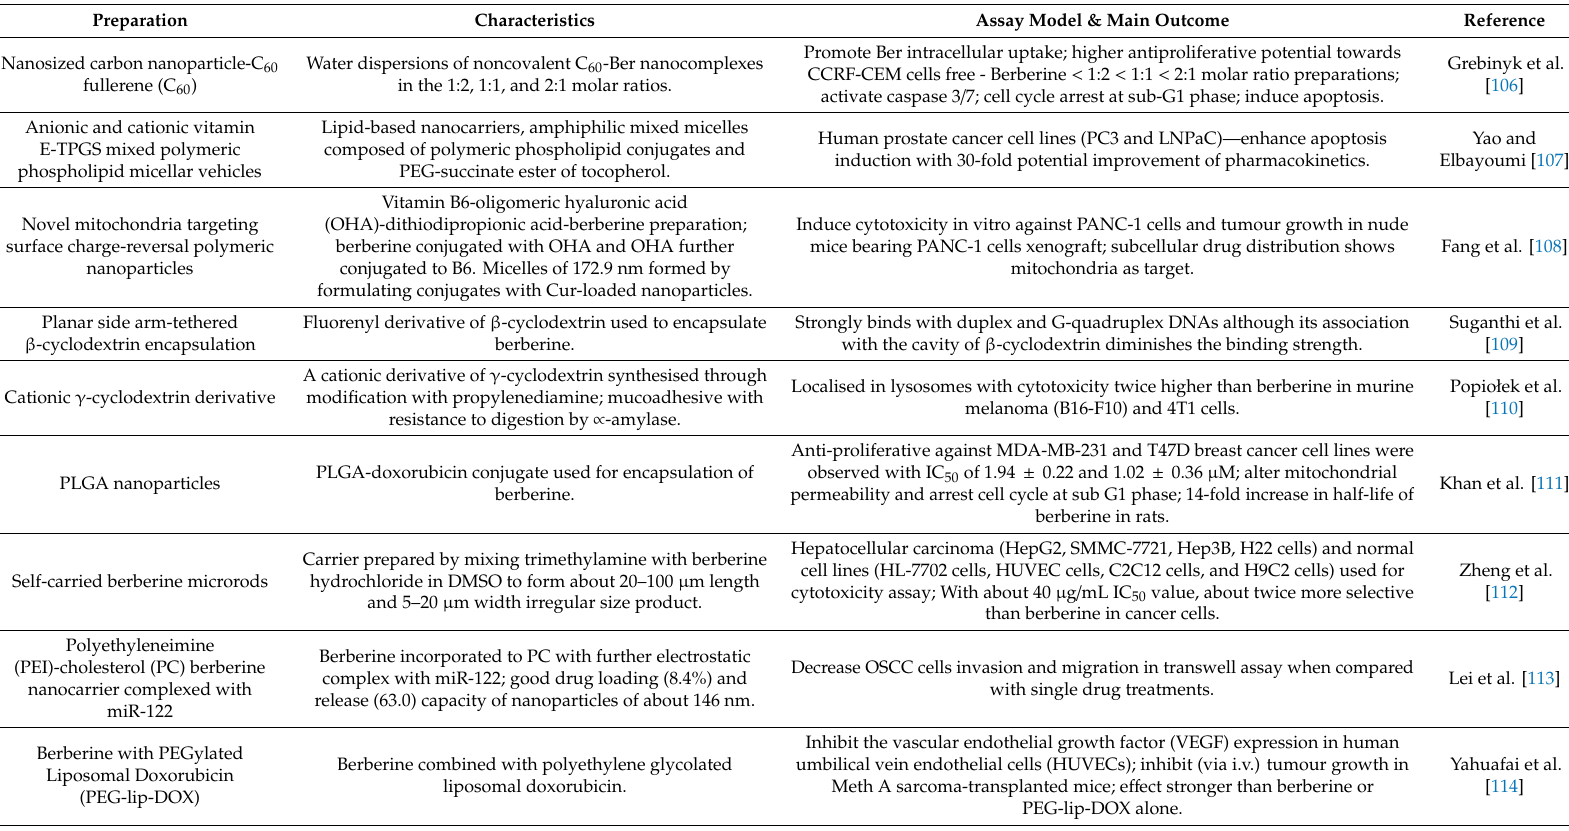
Table 2. Formulation technologies designed to improve the bioavailability and e ffi cacy of berberine as anticancer